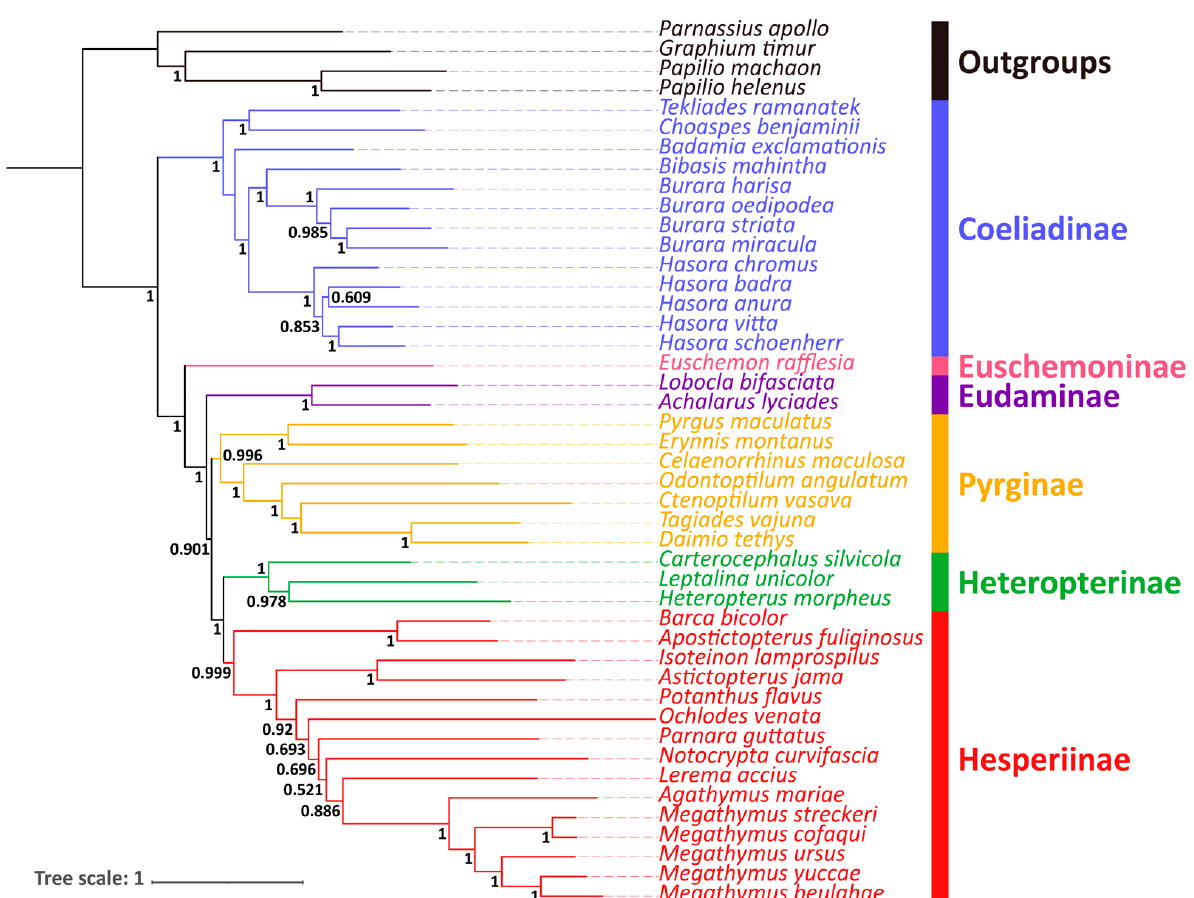
Figure 5. Phylogenetic relationships inferred by the BI method based on the PRT dataset. Numbers on nodes are the posterior probabilities (PP).